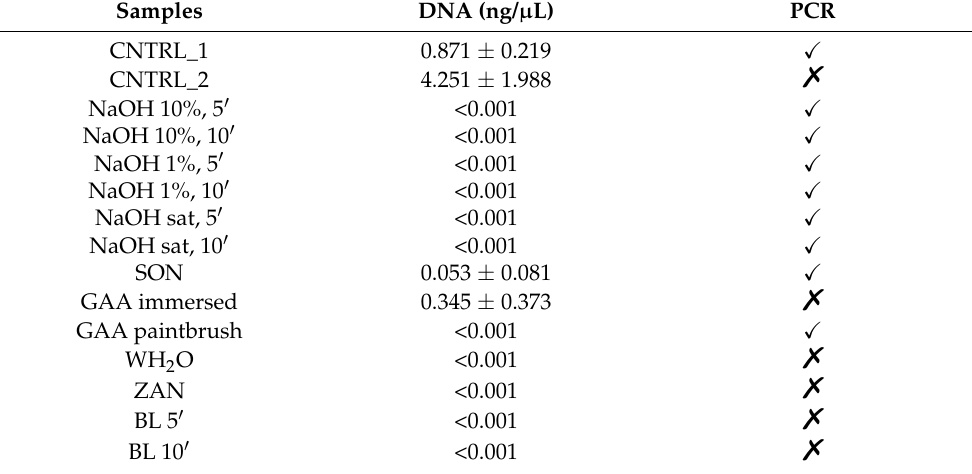
Table 3. Quantifications of DNA (average ± stdev) extracted from the second group of puparia placed in the mixture for a week and then cleaned (CNTRL1 = puparia not placed in the mixture and not cleaned; CNTRL2 = puparia placed in the mixture and not cleaned; NaOH = sodium hydroxide; SON = sonication; GAA = glacial acetic acid; WH 2 O = water/soap; ZAN = hydrochloric acid/sodium bicarbonate solutions; BL = bleach; (cid:88) positive results for the expected fragment, (cid:37) negative results for the expected